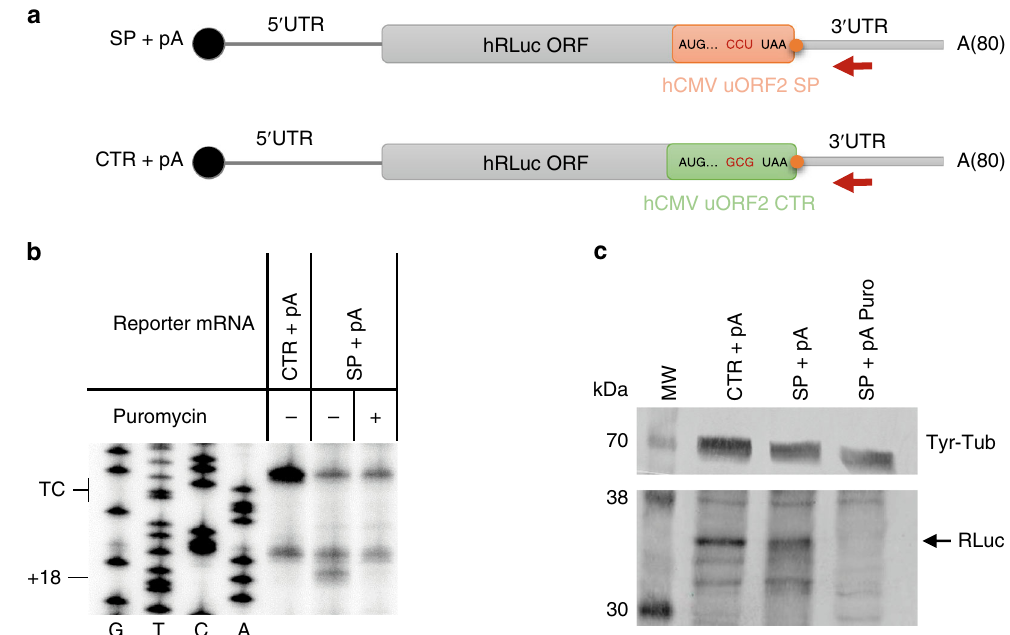
Fig. 2 Stable ribosome stalling caused by the addition of the hCMV uORF2 stalling peptide downstream of the Rluc ORF. a Schematic representation of modi fi ed RLuc reporter mRNA constructs containing the hCMV uORF2 stalling peptide (SP + pA) or a non-stalling control sequence (CTR + pA). The red arrow denotes the radiolabeled toeprint primer and the orange dot the termination codon. The 200-nt long 3 ′ UTR is followed by an 80 nt-long poly(A) tail depicted as A(80). b Toeprint analysis of ribosome occupancy at the TC of the hCMV uORF2 was performed after in vitro translation in HeLa cell lysates for 50 min at 33 °C of equimolar amounts of the two reporter mRNAs described in a . Sanger sequencing reactions were run in parallel (G, T, C, A) to locate the positions of the toeprints. The position of the TC and the toeprint band corresponding to the ribosomes at the TC ( + 18) are indicated. c Representative western blot analysis of an aliquot of the translation reactions analyzed in b . Equal amounts of the translation reactions were separated on a 12% SDS- PAGE, transferred onto a nitrocellulose membrane and probed for tyrosine-tubulin (Tyr-Tub) and Rluc protein. The band corresponding to full-length Rluc protein is denoted by an arrow. The experiment was repeated three times. Source data are provided as a Source Data